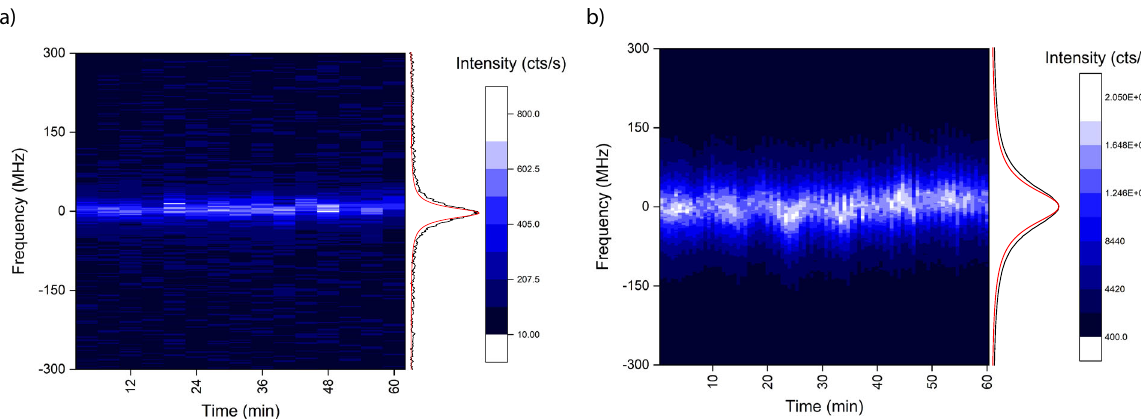
Fig. 3 Long-term stability of the C-transition of SnV − centres. a Low excitation power of 0.5 nW long-term PLE in order to resolve spectral shifts caused by the charge environment or the 445 nm laser without initiating the charge cycle of the centre. The constantly charge stabilised emitter ’ s line position exhibits a standard deviation of less than 4(2) MHz over one hour of measurement. On the right, the integrated spectrum over all scans (black) with a width of 33(2) MHz is compared with the Fourier limited Lorentzian line (red, 25 MHz). b Long-term PLE on Emitter 2 with a power of 10 nW ensuring electron capture in every resonance scan while minimising power broadening. In the duration of one hour, the central resonance position exhibits a standard deviation of 10(2) MHz. The oscillations with a period of about 10 min in the central resonance position are related to the air conditioning cycle in our laboratory. On the right, the integrated spectrum over all scans (black) with a width of 103(2) MHz is compared to a Lorentzian that is only subject to power broadening (red) and exhibits a width of 88 (2)